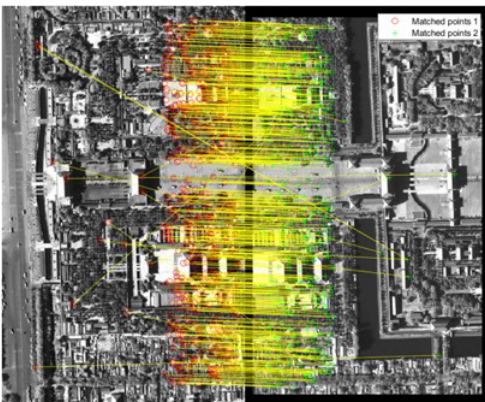
Figure 3. SURF algorithm matching effect diagram